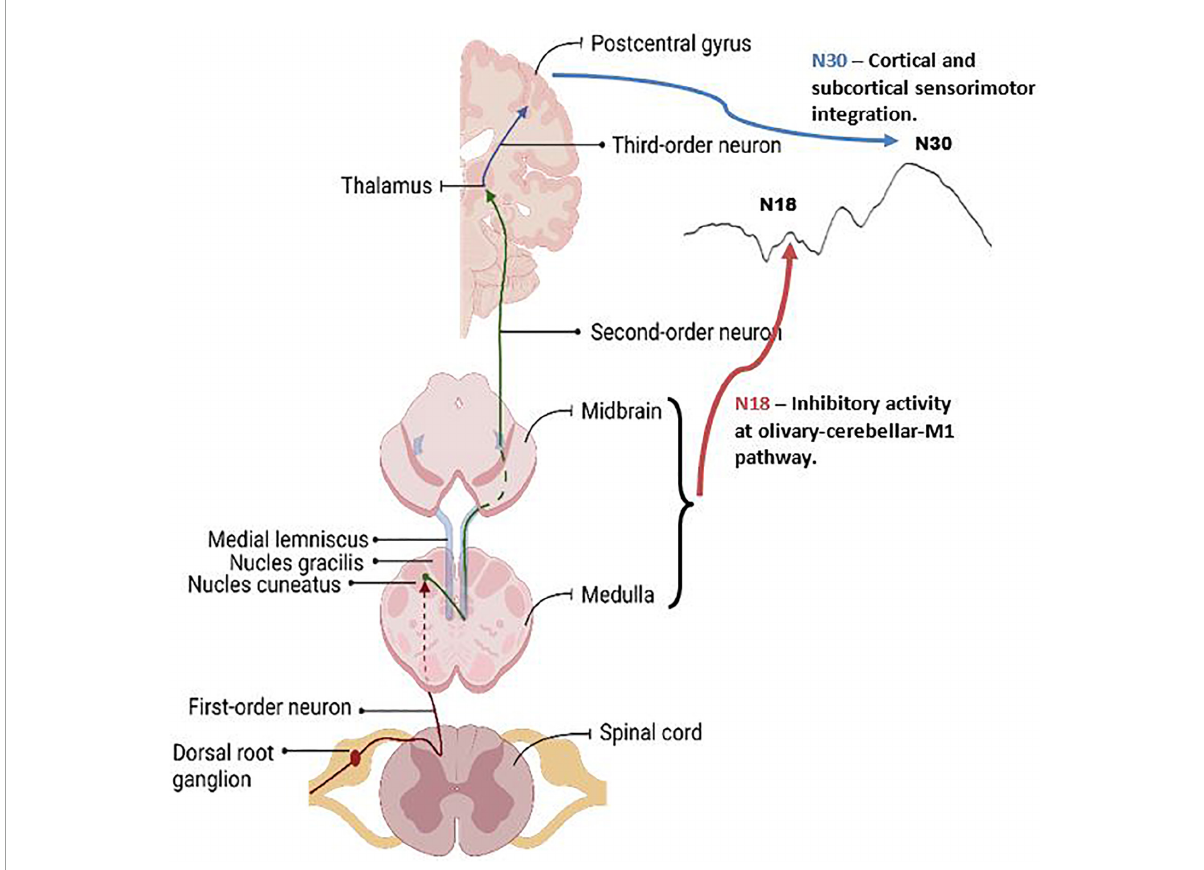
FIGURE9 Graphic of the neuroanatomy and neural generators associated with the SEP peaks that exhibited changes in this paper, the N18 and N30 peaks. The N18 is suggested to reflect inhibitory activity within olivary-cerebellar-M1 locations, and the N30 reflects cortical and subcortical activity associated with sensorimotor integration. Graphic was created with